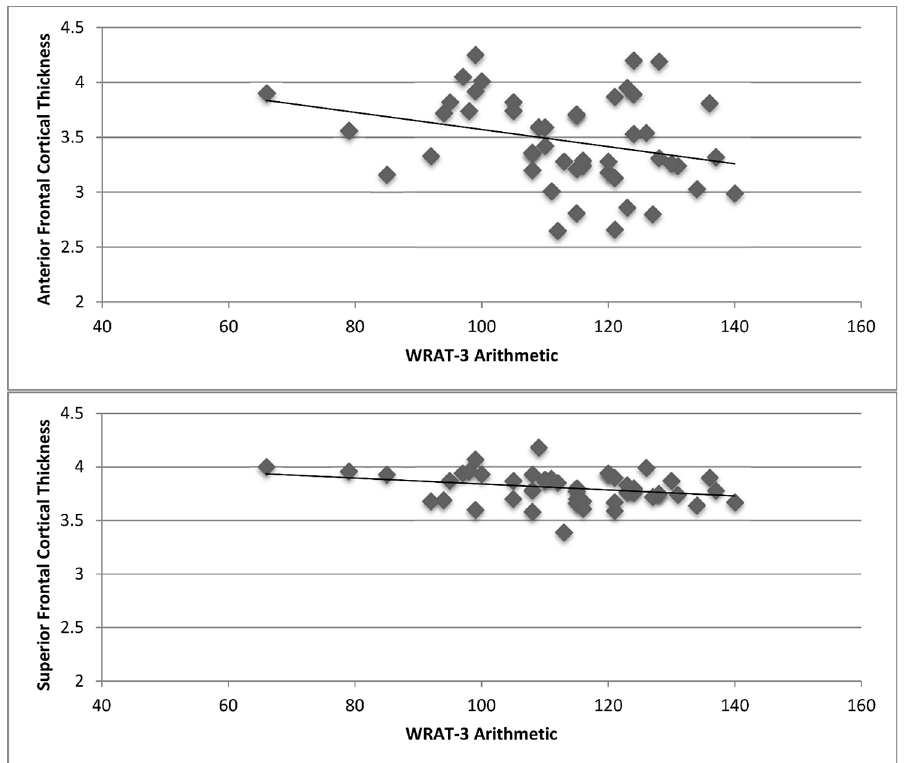
Fig 2. Significant associations between WRAT-3 mathematics achievement and cortical